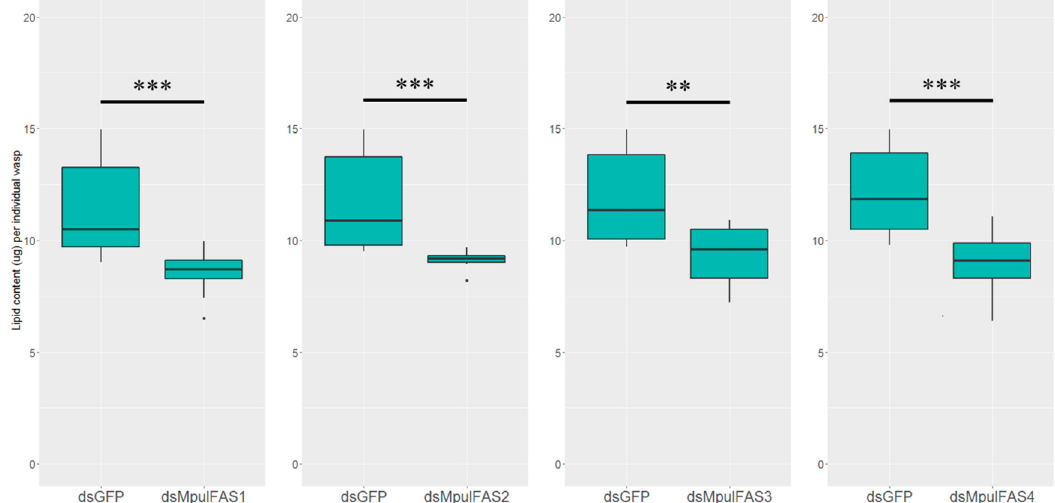
Figure 6. E ff ect of RNAi treatments of MpulFAS s on the lipid content of M. pulchricornis. The lipid content was measured at 48 h after knocking down MpulFAS1 , MpulFAS2, and MpulFAS3 ; for MpulFAS4 , the lipid content was measured at 24 h after dsRNA injection. Di ff erences in lipid content of each treatment were compared using a one-way analysis of variance (ANOVA) with Tukey’s post-hoc test. Significant di ff erences are indicated by asterisks (** p < 0.01, *** p < 0.001).